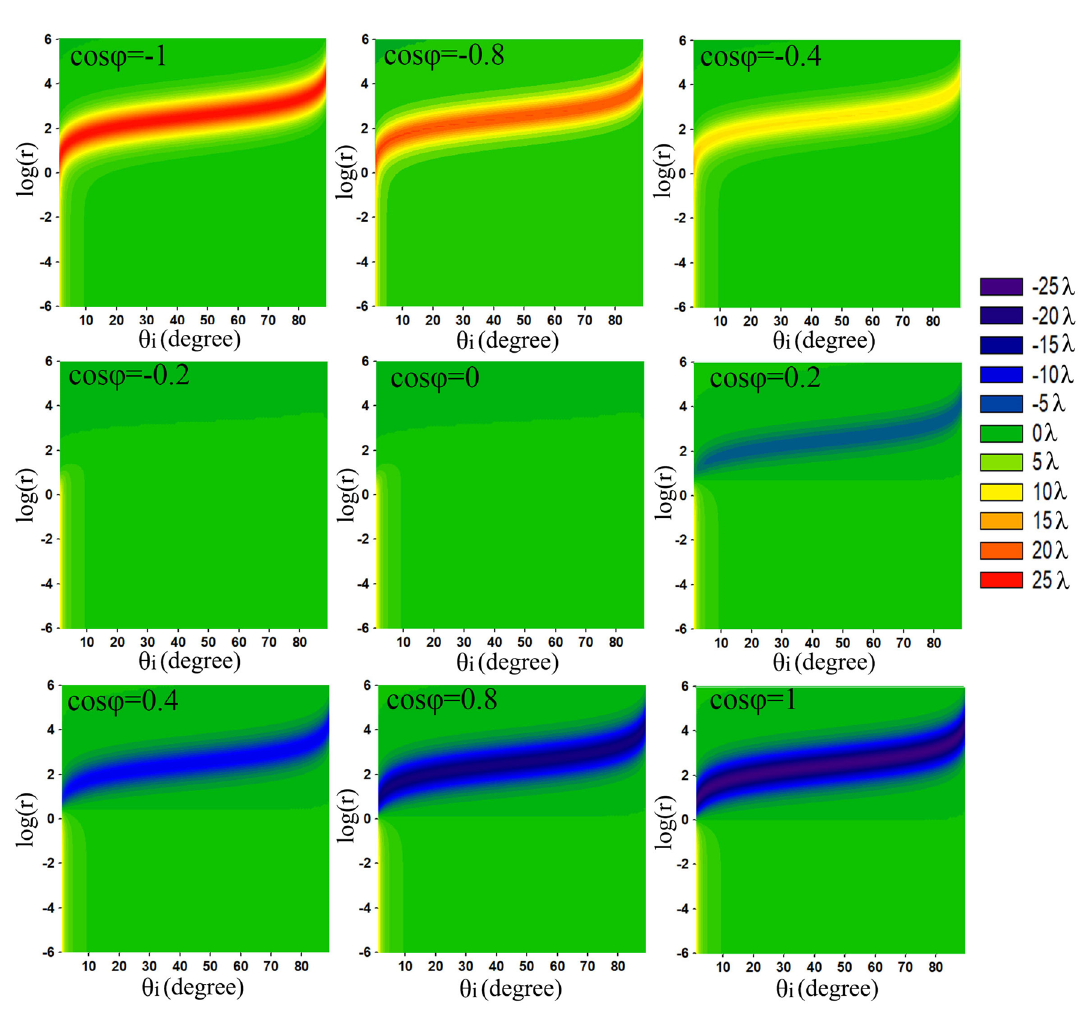
Figure 1. Dependence of the transverse shifts on θ i and log(r) at different values of cosφ, where ω 0 =